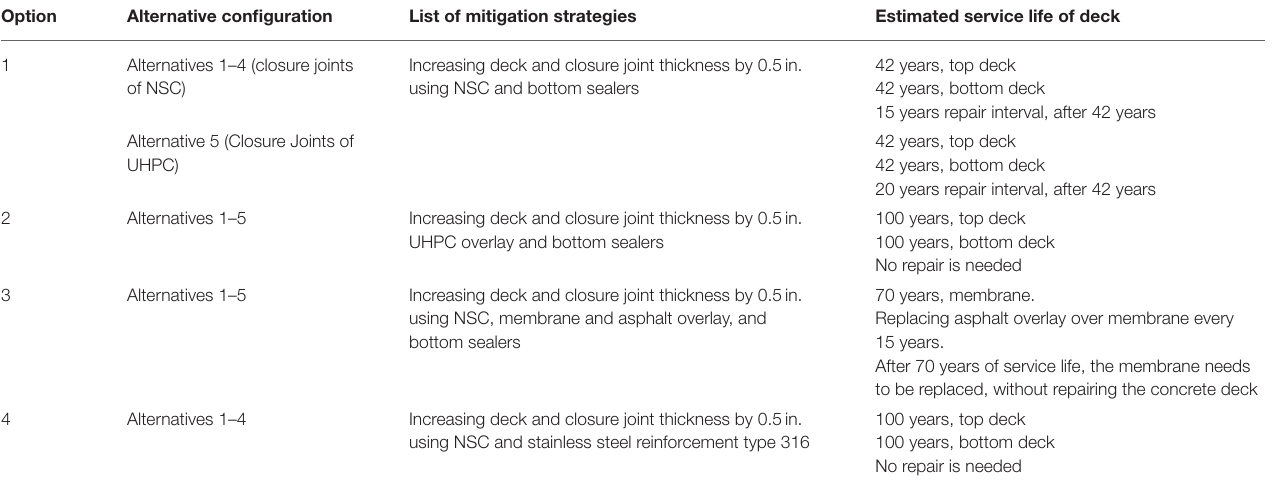
TABLE 7 | Estimated service life and repair interval for each alternative and